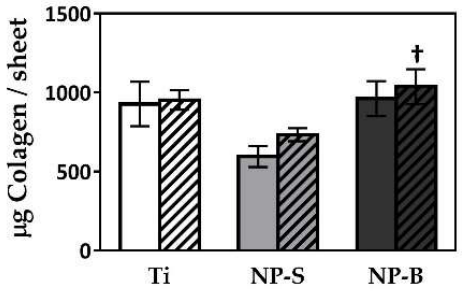
Figure 5. Total collagen content after 14 days of cell culture. Plain bars correspond to donor hGF-A, and striped bars correspond to donor hGF-B. Values represent the mean ± SEM ( n = 3) for each donor. Significant differences were assessed by ANOVA and post-hoc LSD test: † p < 0.05 versus NP-S.